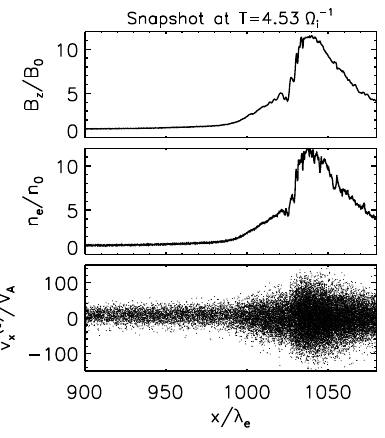
Figure 1. Snapshot of the magnetic field (the z component), the electron density, and the subset of electron phase-space density at the time around 4.5 ion gyroperiods. The magnetic field and the electron density are normalized to the respective background